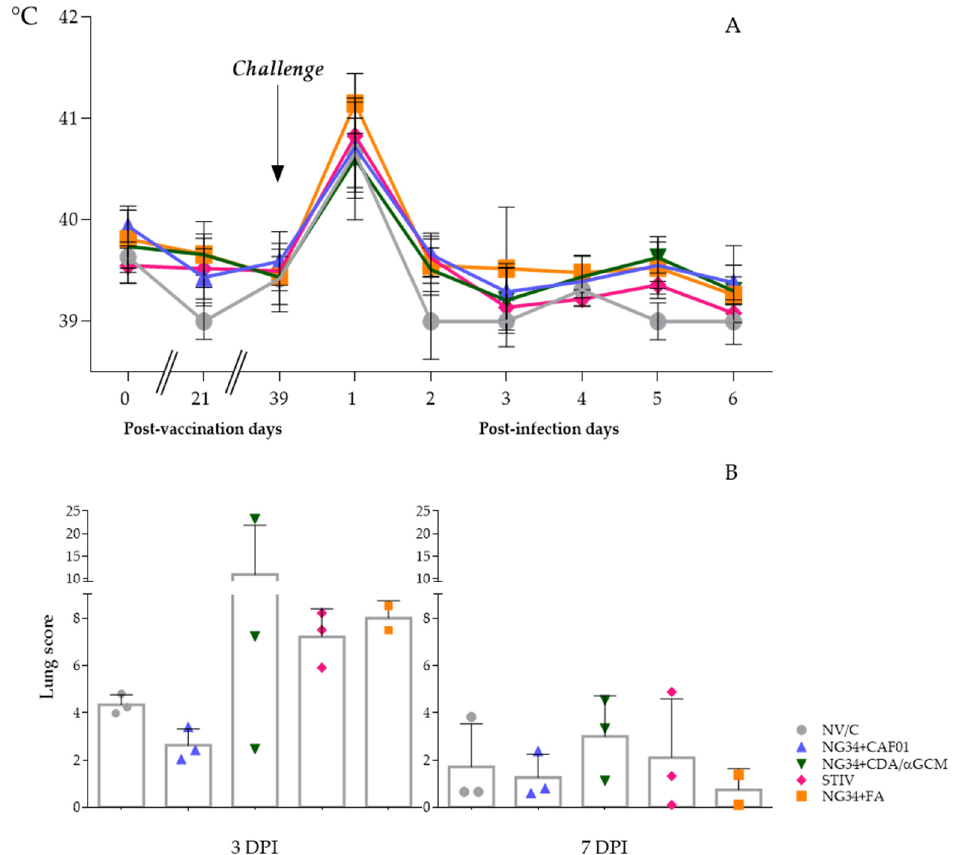
Figure 1. Graphs depicting average and SD of rectal temperatures taken during the experiment ( A ) and Influenza like pulmonary cranio-ventral consolidation lesions observed in animals euthanized at 3 and 7 days after the infection ( B ).